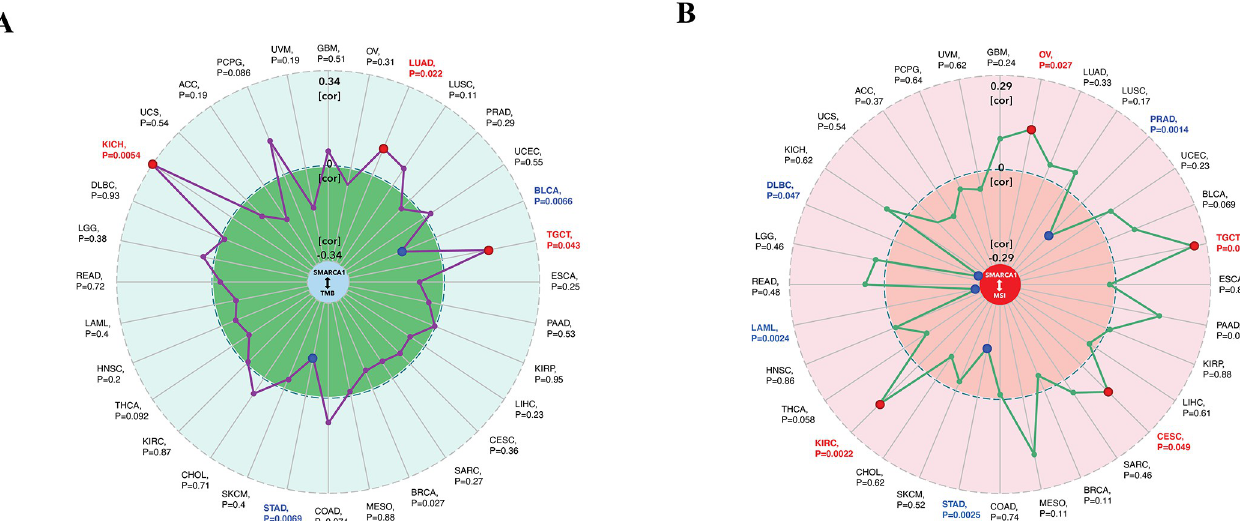
Fig 12. Correlation analysis between SMARCA1 and TMB/MSI. (A) Gene-immune analysis of the potential correlation between SMARCA1 expression and TMB across all cancers in TCGA. The partial correlation values (cor) of +0.34 and -0.34 are marked. (B) Gene-immune analysis of the potential correlation between SMARCA1 expression and MSI across all cancers in TCGA. The partial correlation values (cor) of +0.29 and -0.29 are marked. � P -value < 0.05. TMB: tumor mutational burden; MSI: microsatellite instability.